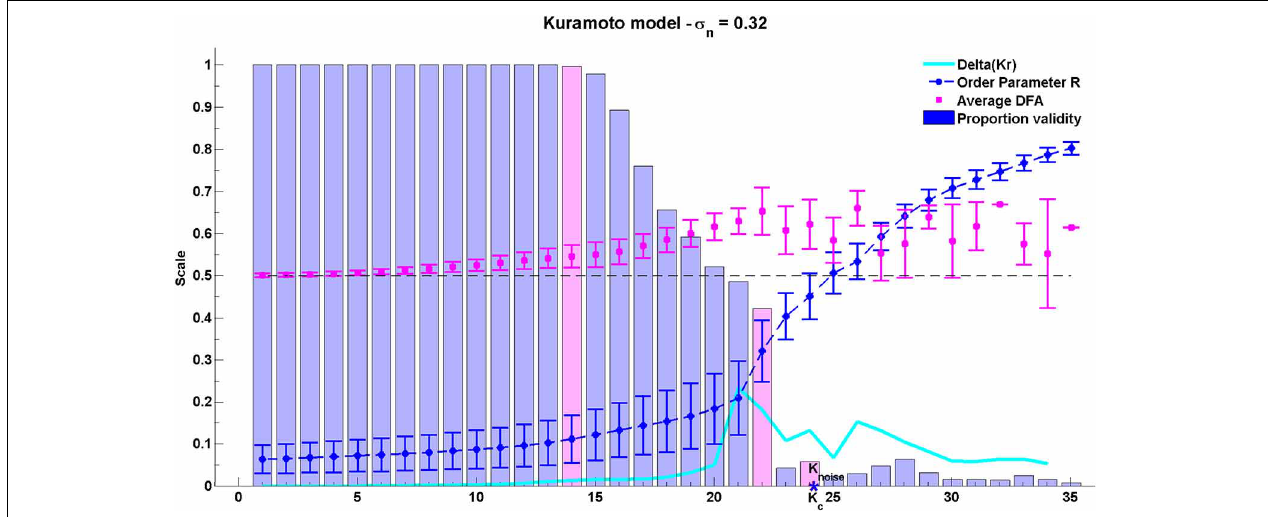
FIGURE 8 | Results of the phase synchrony analysis method when applied to the Kuramoto model. There are 200 oscillators, with a mean natural frequency of 22 Hz, and a standard deviation of natural frequencies of 15. The theoretical critical coupling K noise when noise is added is marked with